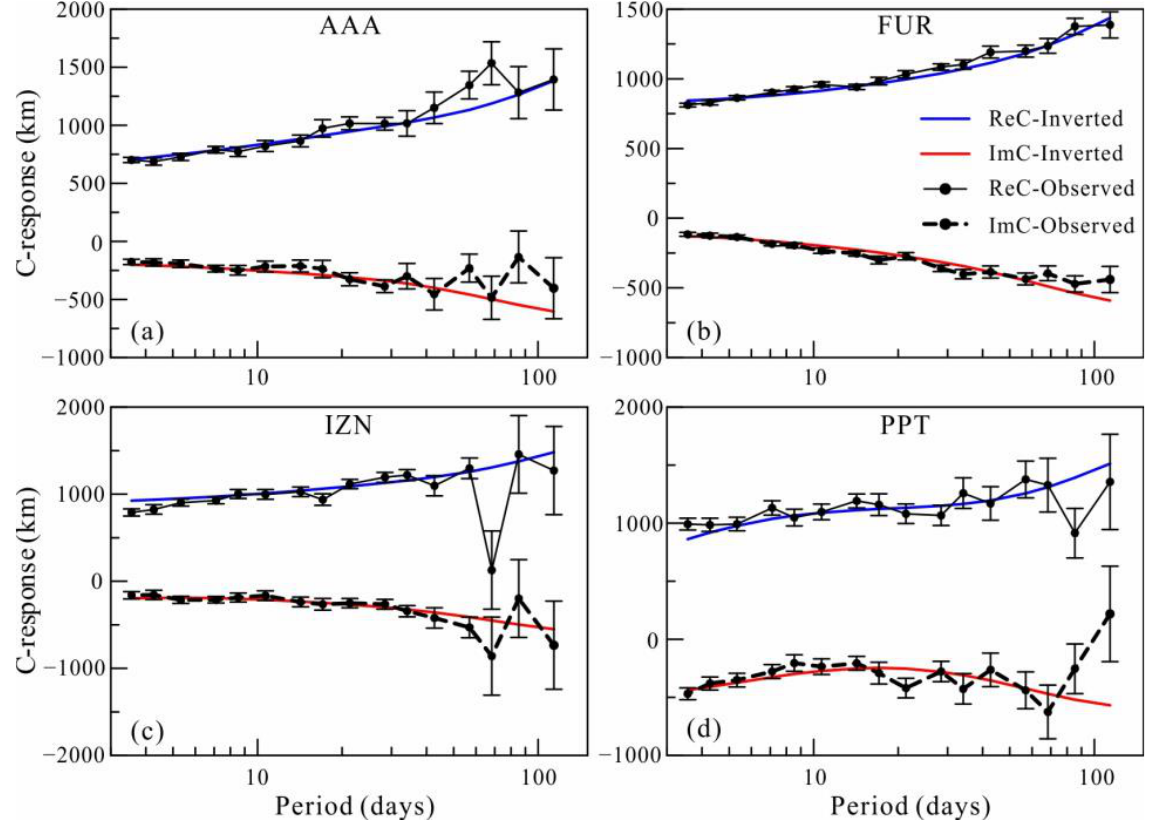
Figure 11. Fitness curves of response of inversion results and the observed C -response for four geomagnetic observatories. ( a ) for AAA, ( b ) for FUR, ( c ) for IZN, and ( d ) for PPT.